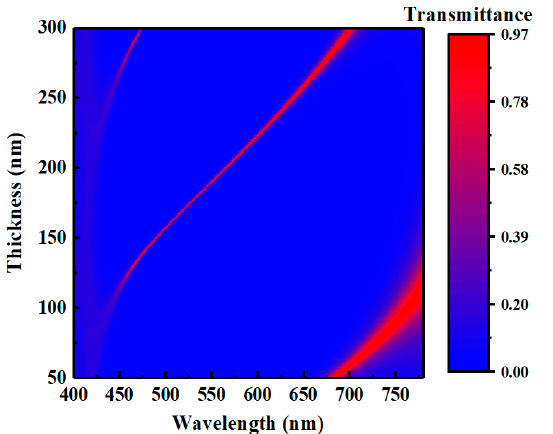
Figure 4. Evolution of the transmissive spectrum of the FP cavity as the thickness of interlayer changes.